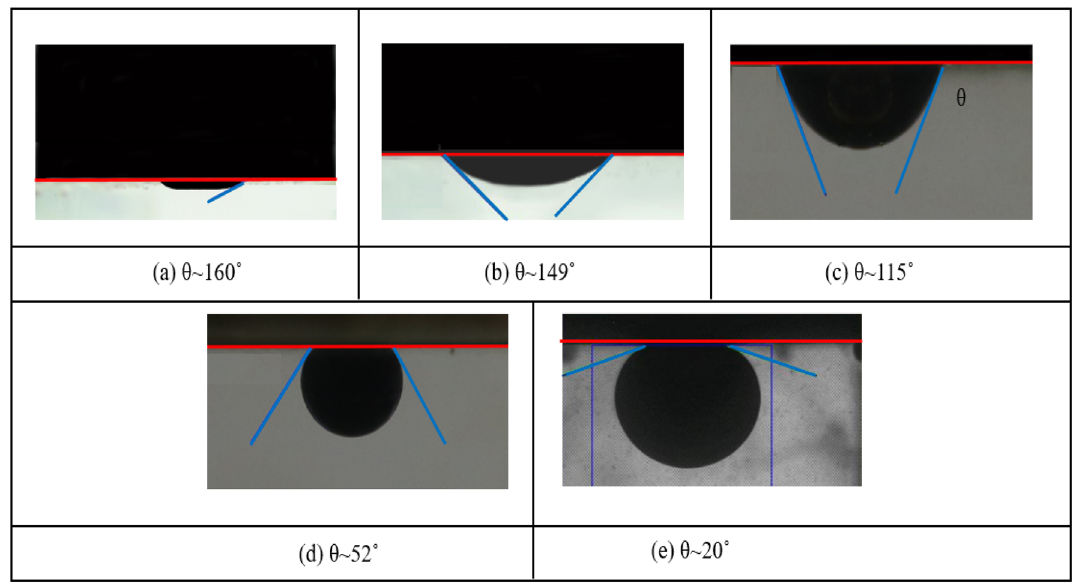
Figure 2. Contact angle measurements on the carbonate rock surface in solutions ( a ), reference oil-wet sample, ( b ) SWP without any particles, ( c ) 500-PE-cit-AQDs nanofluid, ( d ) 1000-PE-cit-AQDs nanofluid, ( e ) 500-PE-cit-ANPs nanofluid; Aging time = 72 h; Temperature = 90 °C, Pressure = 750